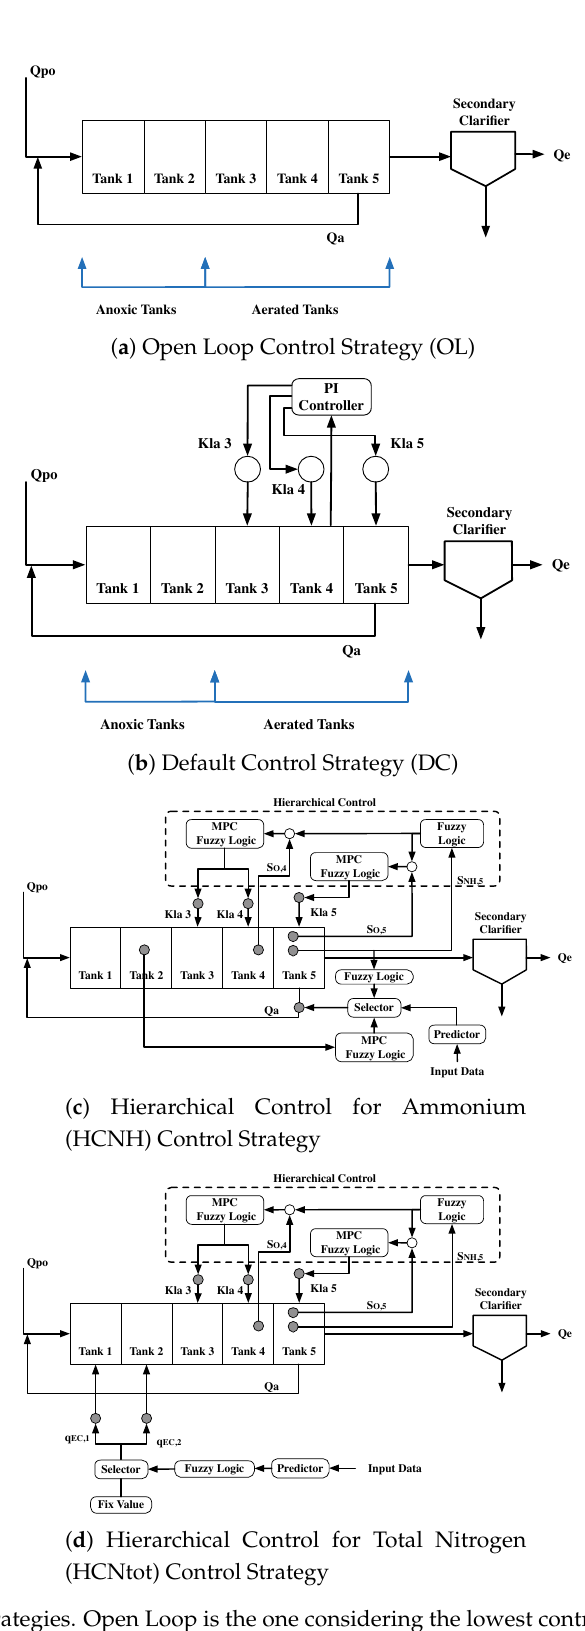
Figure 2. Control strategies. Open Loop is the one considering the lowest control level, whereas the highest one is considered in the HCNH and HCNtot Control